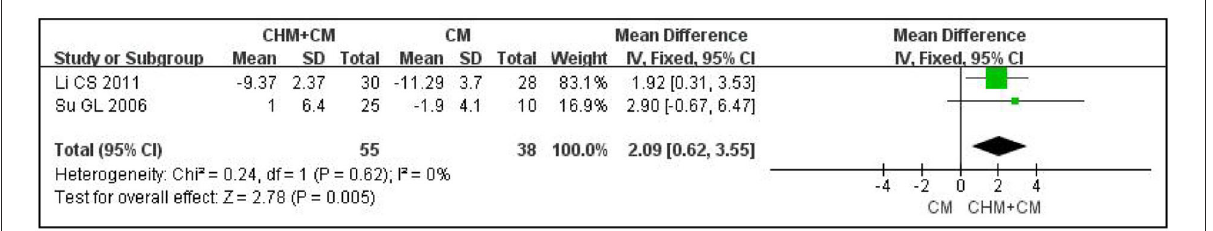
to.62; P = 0.38; I 2 = 0%; n = 2 RCTs; 189 participants) (17, 28).